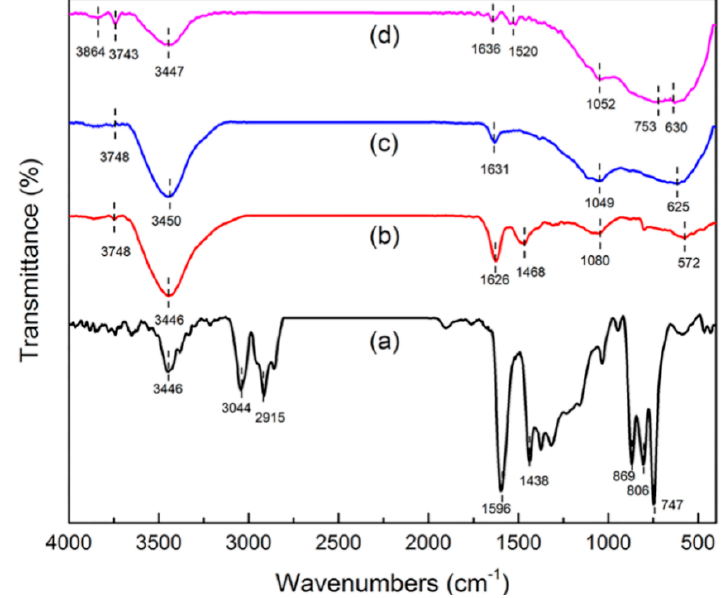
Figure 3. Fourier transform infrared spectroscopy (FT-IR) spectra of (a) green petroleum coke, (b) N-GLPs 350 2 , (c) N-GLPs 550 2 , and (d) N-GLPs 750 2 .